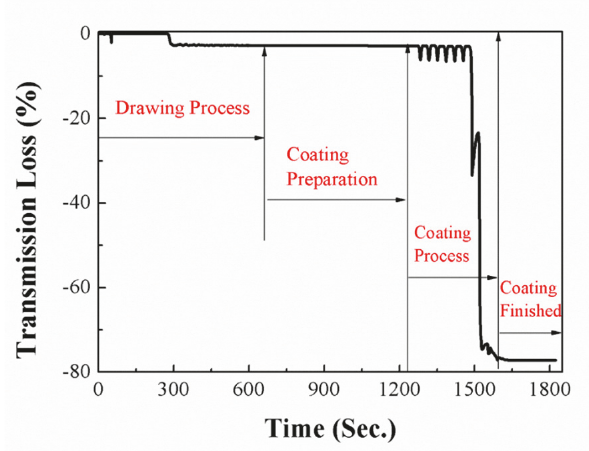
Figure 3: Transmission loss of OFM during drawing and coating